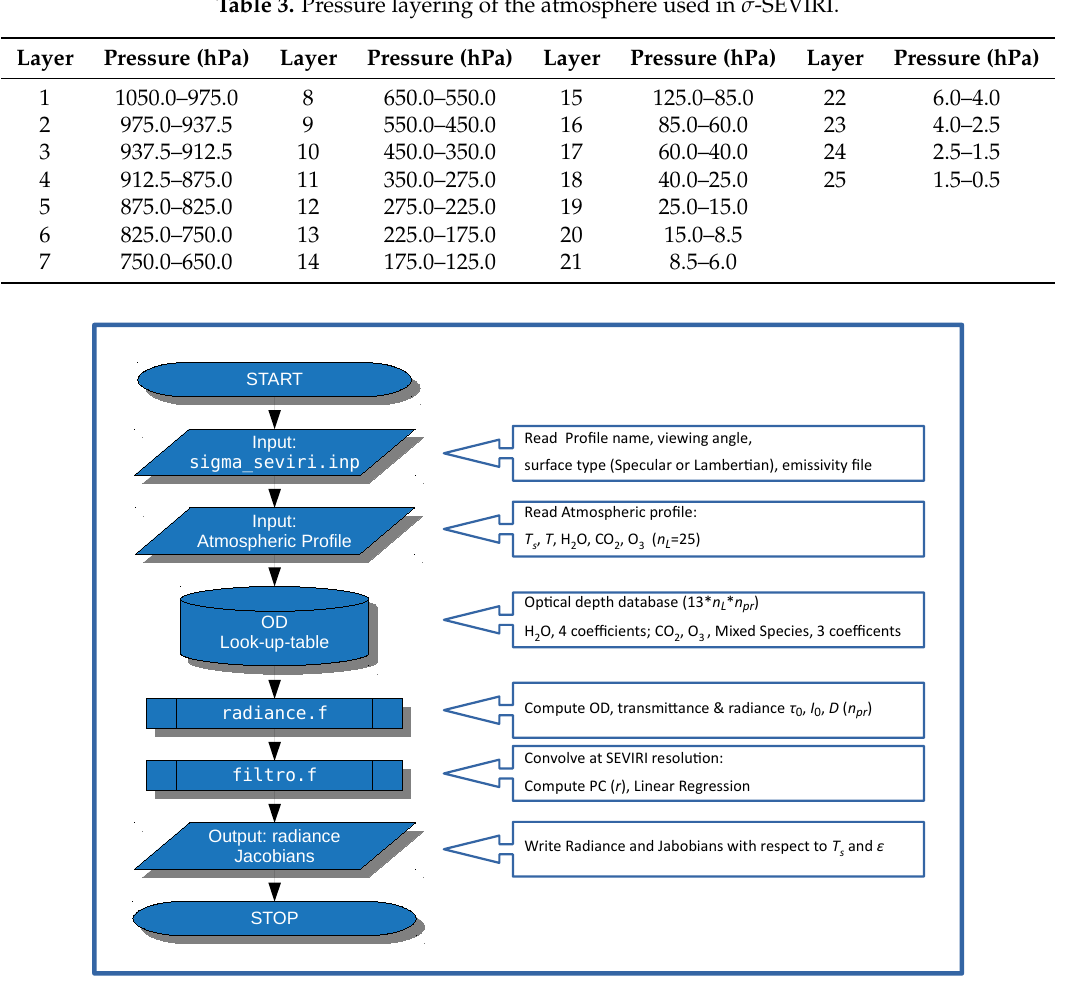
Figure 4. σ pc -SEVIRI radiative Transfer flow